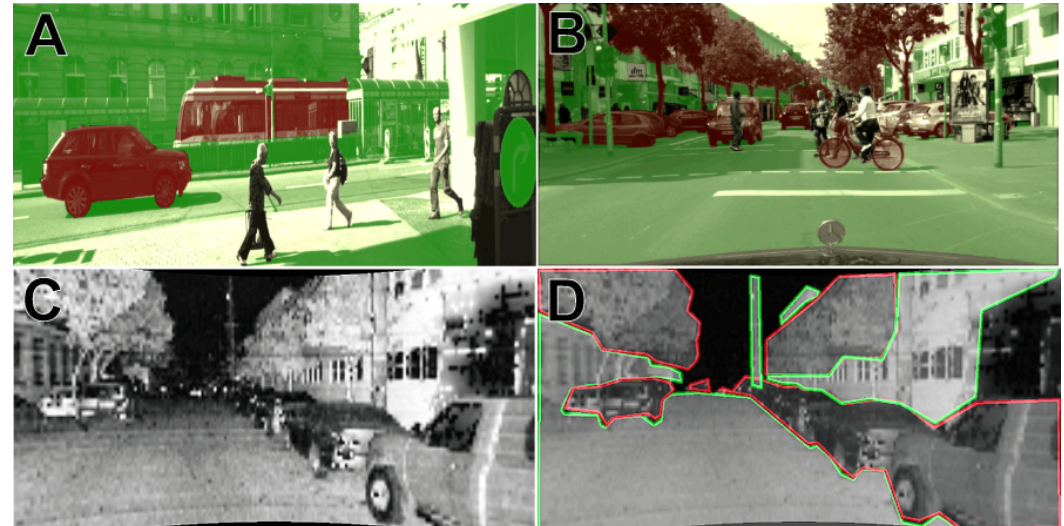
Figure 5. Example from CityScapes ( A ) and KITTI ( B ) used in pre-training, intensity image from Ouster OS1-64 ( C ) with manual labeling ( D ): Class_1 is green, Class_ 2 is red, Class_3 without